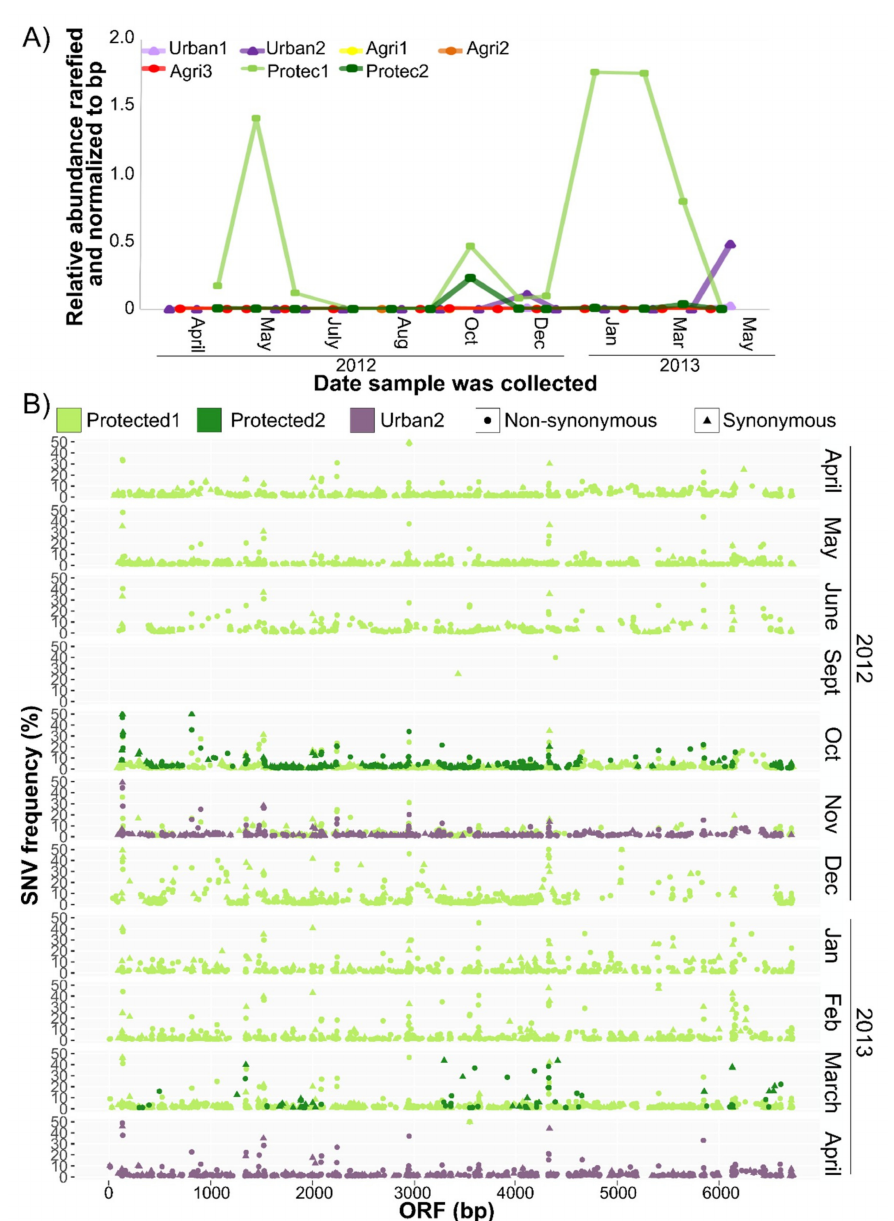
Figure 6. CV-Can contigs were abundant and diverse in freshwater streams. Relative abundances calculated from rarefied read counts and normalized by contig size ( A ) suggest that CV-Can was most abundant at the first protected site (Prist1) compared to the urban and agricultural (Agri) sites. Single nucleotide variant (SNV) analysis ( B ) of the replicase gene at the two protected and one urban site indicate much genetic variation within the CV-Can